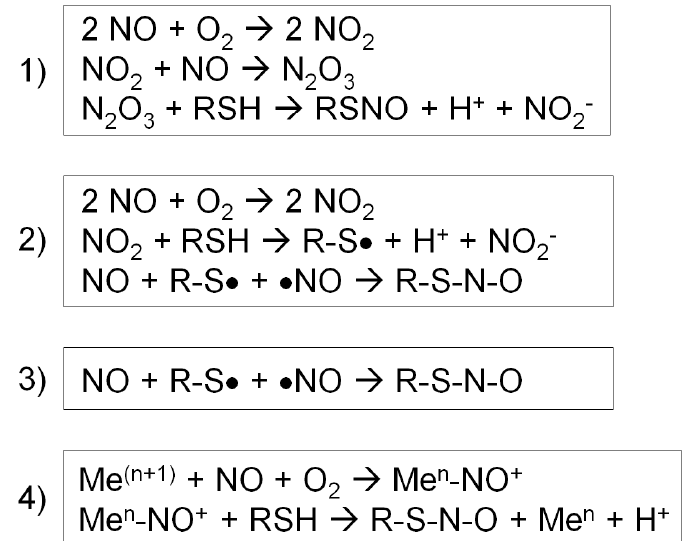
Figure 2. Four different types of S-nitrosylation reactions [56]. (1) Nitric oxide (NO) reacts with O 2